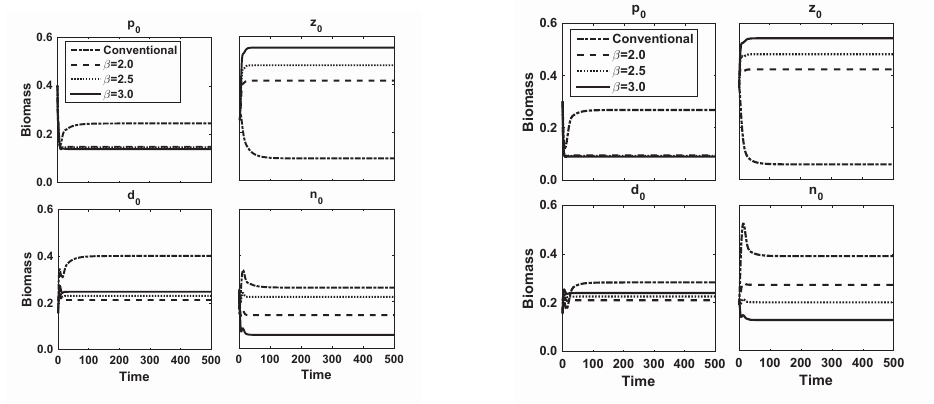
Figure 2. A significant enhancement in Z-biomass for P-dominating and Z-dominating cases. Pertur- bations lead higher biomass in top trophic level of NPZD system